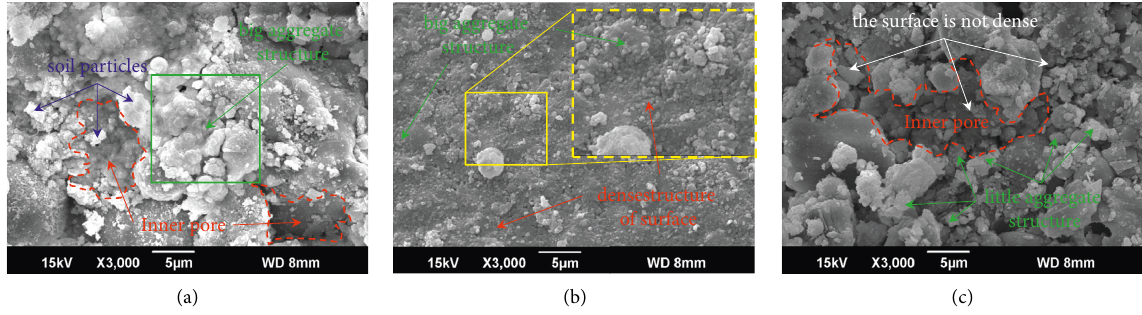
Figure 10: Scanning of internal structure of